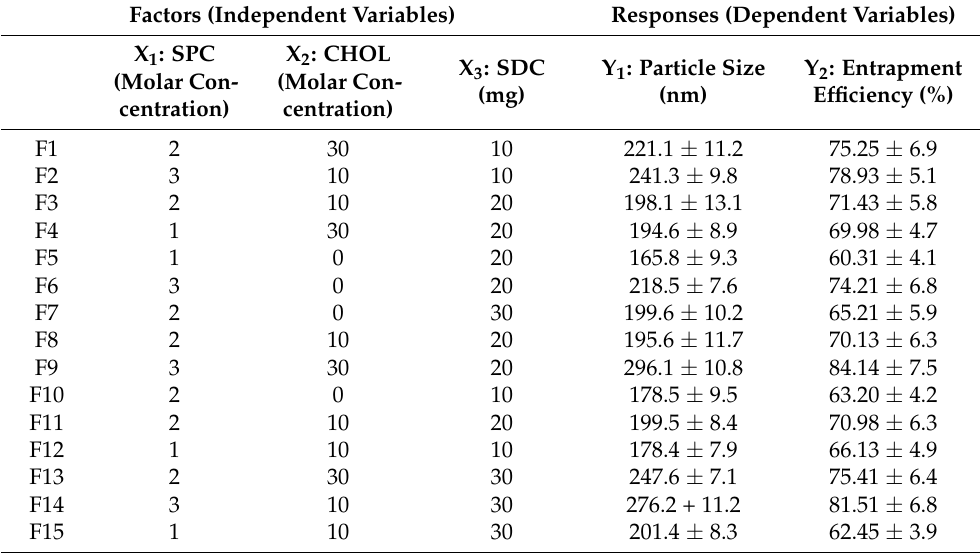
Table 2. Composition of the formulated VDF-loaded bilosomal formulations and the obtained